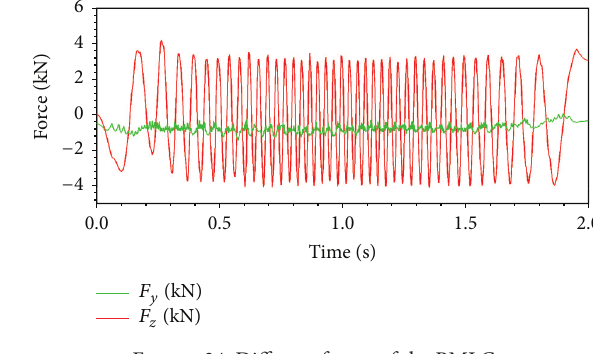
Figure 24: Different forces of the PMLG.